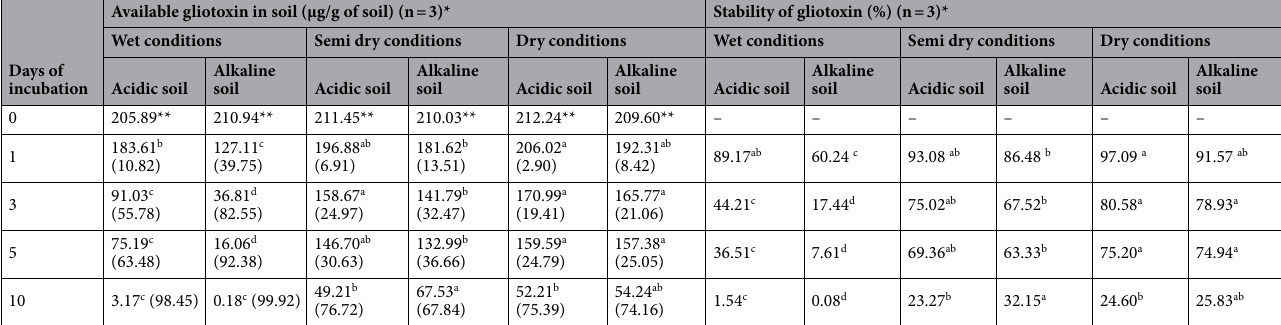
Table 3. Stability of gliotoxin in unsterile soil. In each row, the mean values followed by a common letter or ** are not significantly different (p ≤ 0.05, DMRT analysis). Statistical analysis was carried out separately for available gliotoxin and stability of gliotoxin. Values in the parentheses are percent degradation of gliotoxin. *Values are means of three replications.